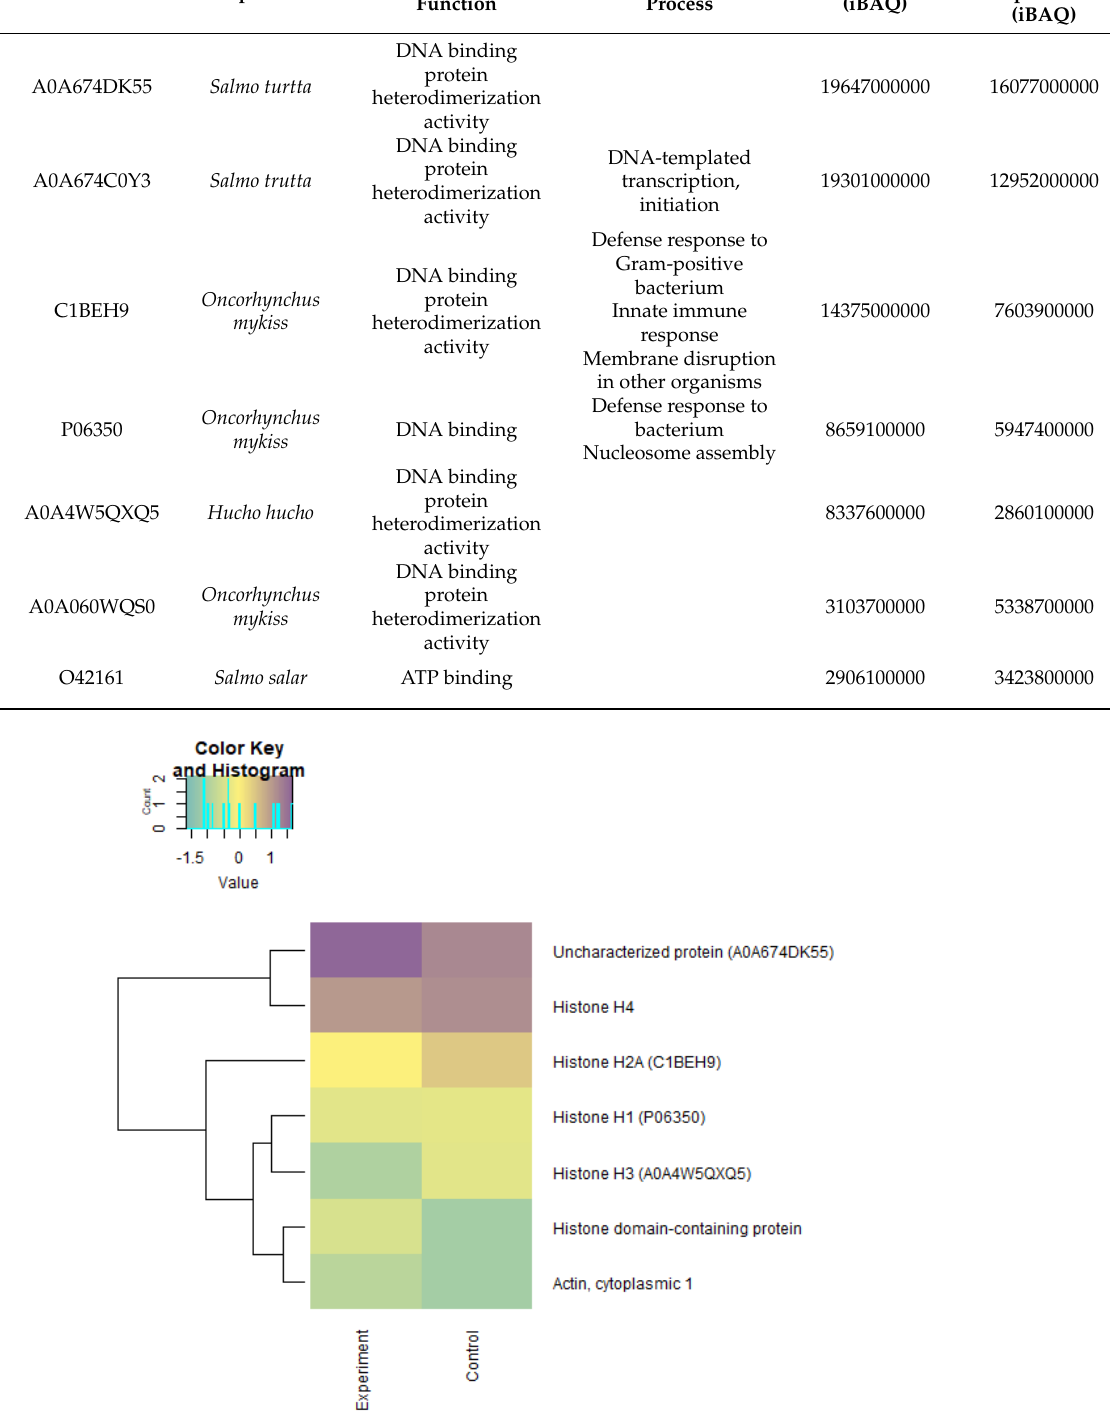
Figure 13. Heatmap LFQ Z- scores of normalized data of a “high concentration” proteome (group 1) in underyearlings of Atlantic salmon ( Salmo salar L.) for control and experimental groups.